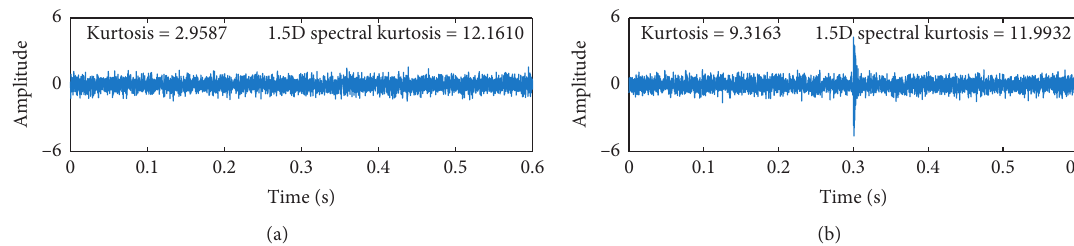
Figure 3: Analysis of simulated signals. (a) Gaussian noise; (b) noise accompanied by nonperiodic transient impulse.